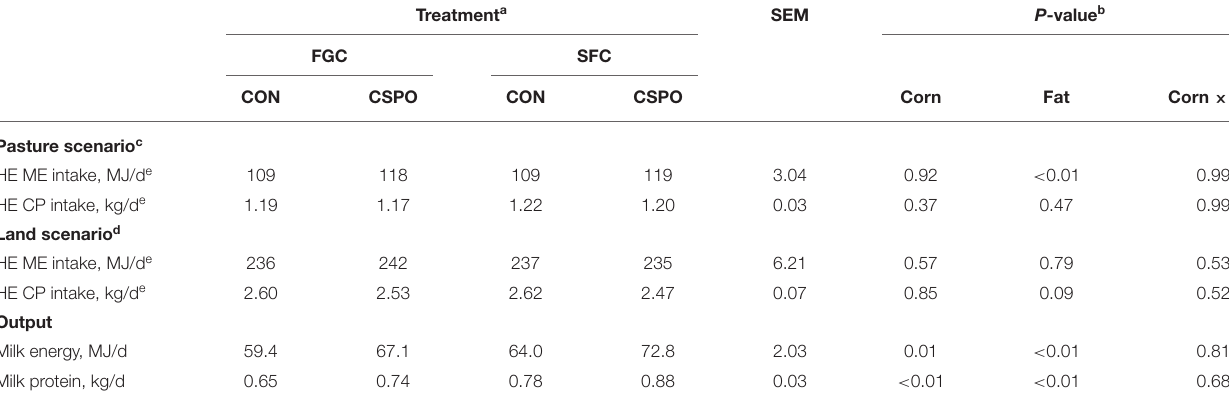
TABLE 4 | Human-edible (HE) nutrient inputs and outputs of dairy cows receiving the treatment diets (Experiment 1). Treatment a SEM P -value b FGC SFC CON CSPO CON CSPO Corn Fat Corn × Fat Pasture scenario c HE ME intake, MJ/d e